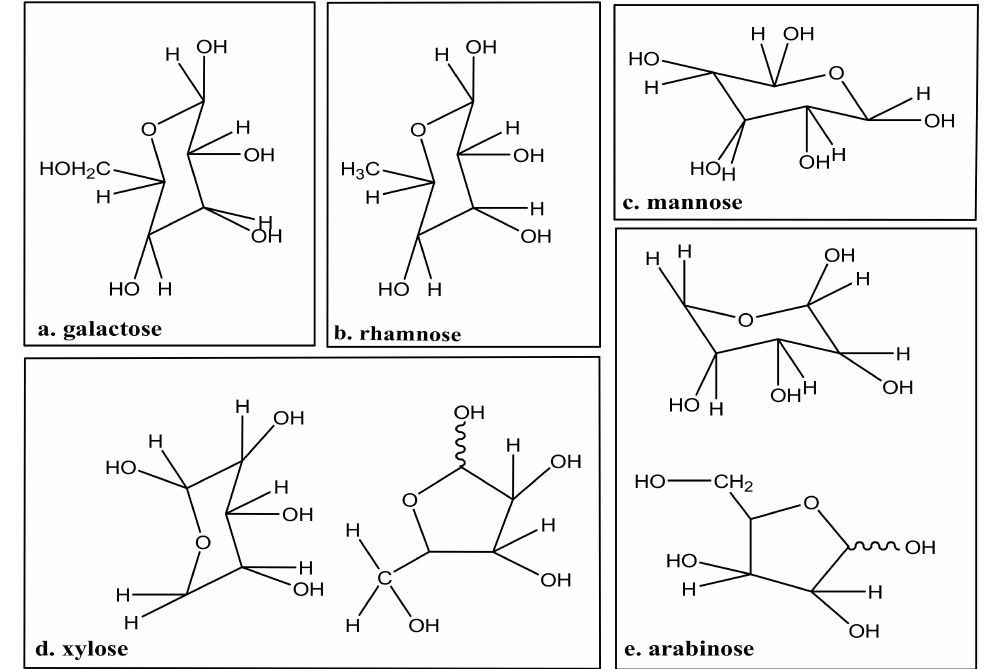
Figure 2. Chemical models of sugar in